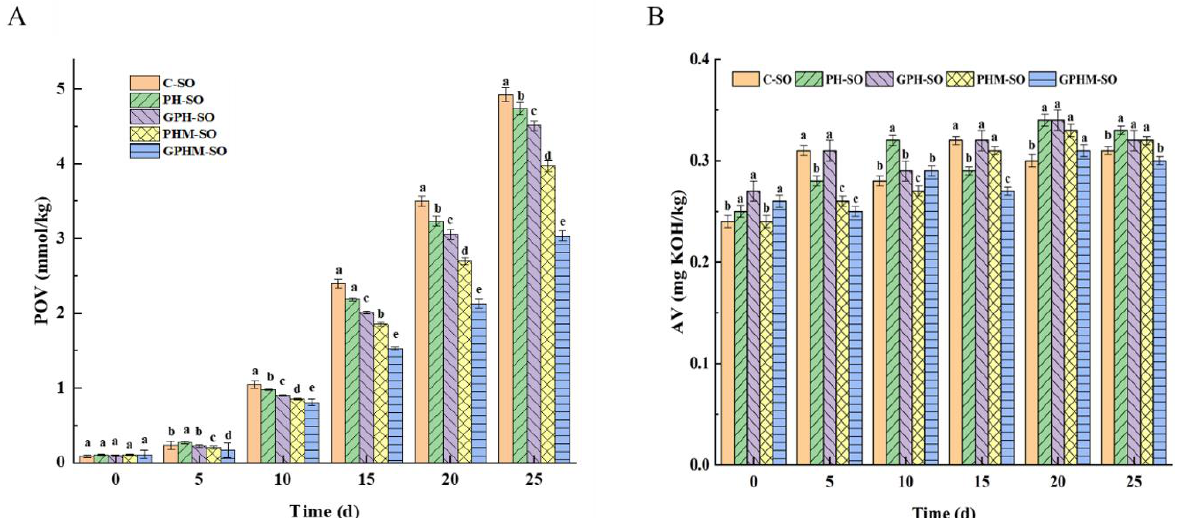
Figure 3. Changes in oxidative stability of the resulting oils during 60 ± 3 °C accelerated oxidation. ( A ) Peroxide value and ( B ) acid value. Note: Values followed by different lowercase letters (a–e) mean statistically significant differences ( p < 0.05) among different kinds of oils. Table 6. Fitting equation between peroxide value (y) and storage time (x) during 60 ± 3 °C acceler- ated oxidation.